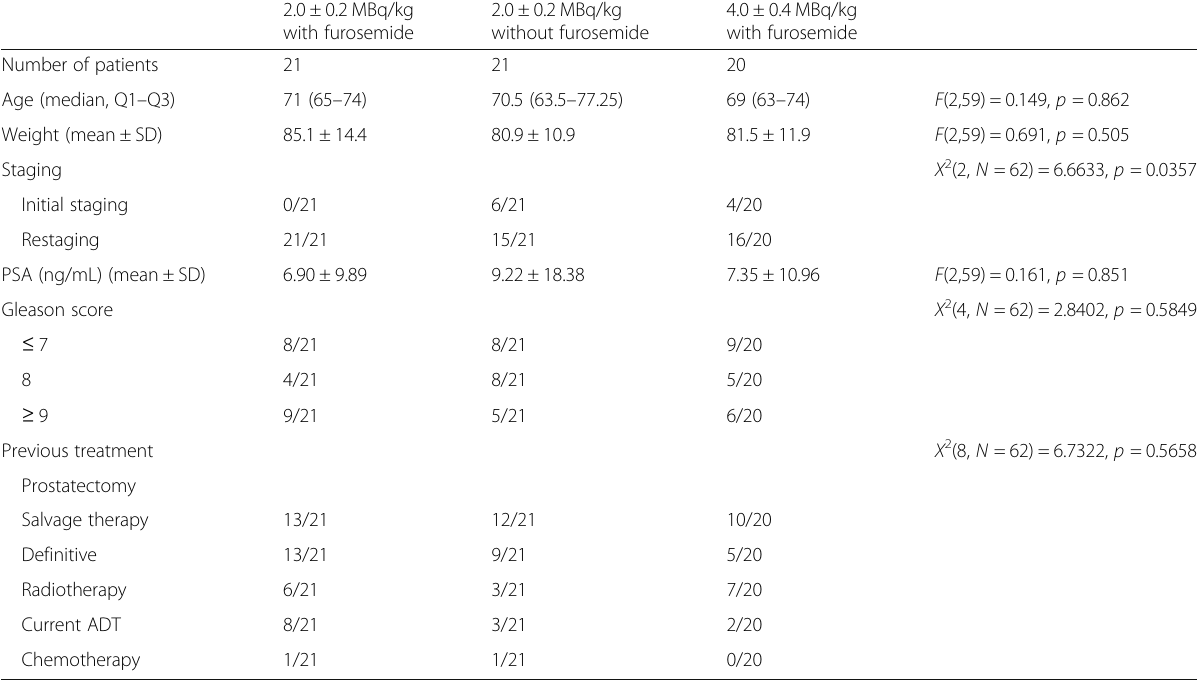
Table 1 Patient characteristics of patients who completed all planned procedures. Chi-square and one-way ANOVA was performed for categorical and continuous variables,